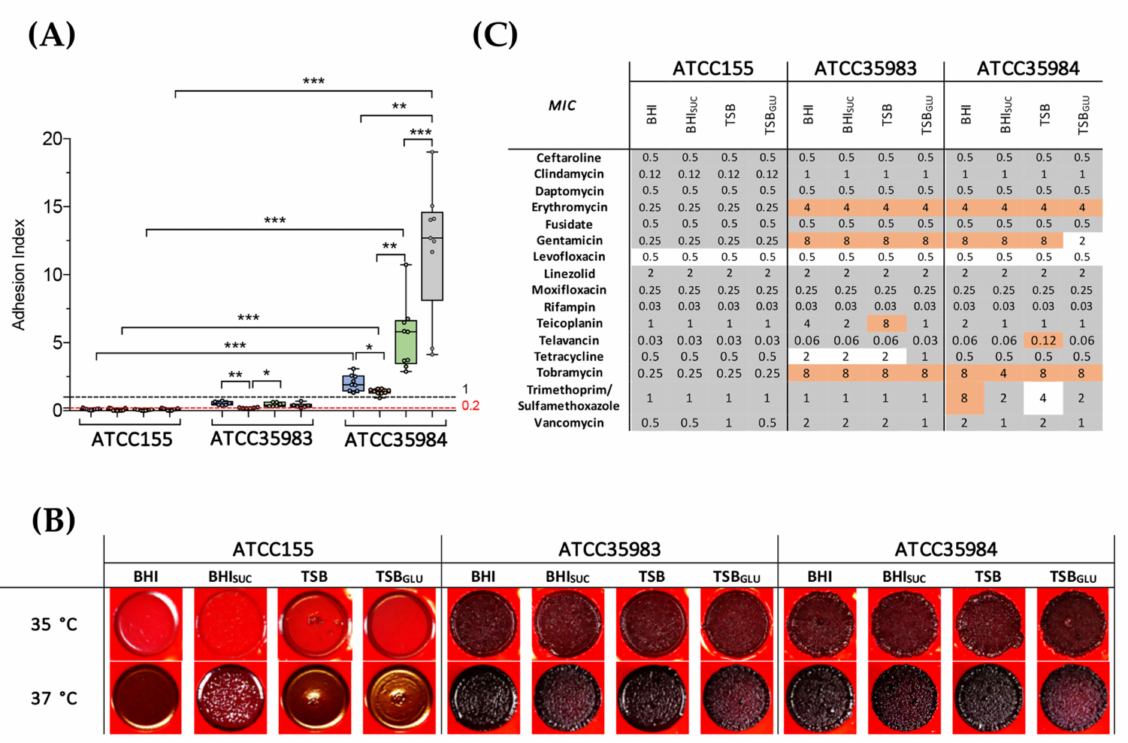
Figure 1. The phenotypic profile of S. epidermidis refence strains. ( A ) Biofilm formation determined with the CV assay of the indicated S. epidermidis reference strains in BHI in the presence or absence of 2% sucrose (BHI SUC ), or TSB in the presence or absence of 1% glucose (BHI SUC ). Data are represented with Box-plots showing each value as dots, the median as horizontal lines, and range with upper and lower quartiles of at least three independent experiments. Statistical significance for each condition was reported (* p < 0.05, ** p < 0.01, *** p < 0.001). ( B ) Qualitative detection of the slime formation on Congo Red agar (CRA) plates of the indicated refence strains at 35 ◦ C (upper panel) and 37 ◦ C (lower panel). ( C ) The MIC values of the S. epidermidis reference strains grown in different indicated media. Each experiment was performed in triplicate. Resistant strains or with a MIC value higher then MIC90 was reported in red; susceptible or with a MIC value lower then MIC90 was reported in grey; and susceptible-increased exposure in